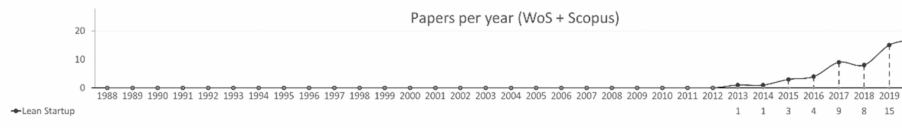
Figure 18. Lean startup